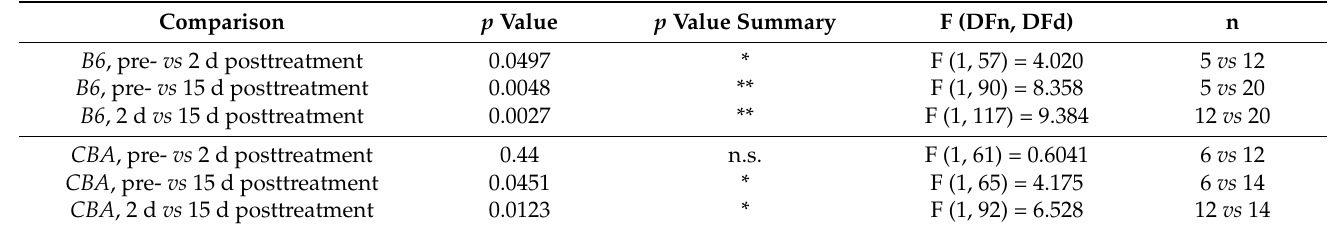
Table 2. Ordinary two-way ANOVA statistics on 400 G/200 F-induced variation of ribbon